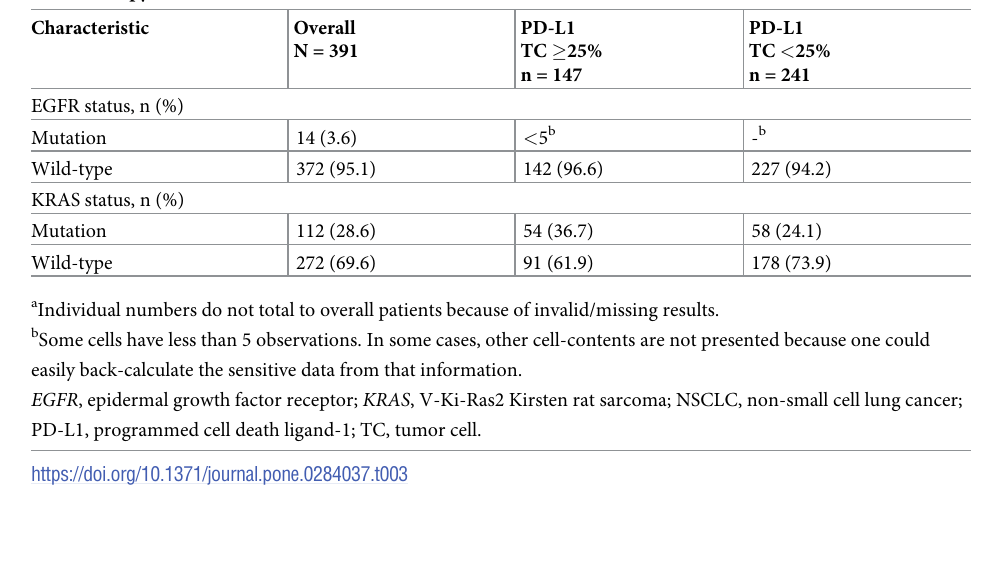
Table 3. PD-L1 expression level by EGFR and KRAS mutation status in patients with NSCLC receiving adjuvant chemotherapy a